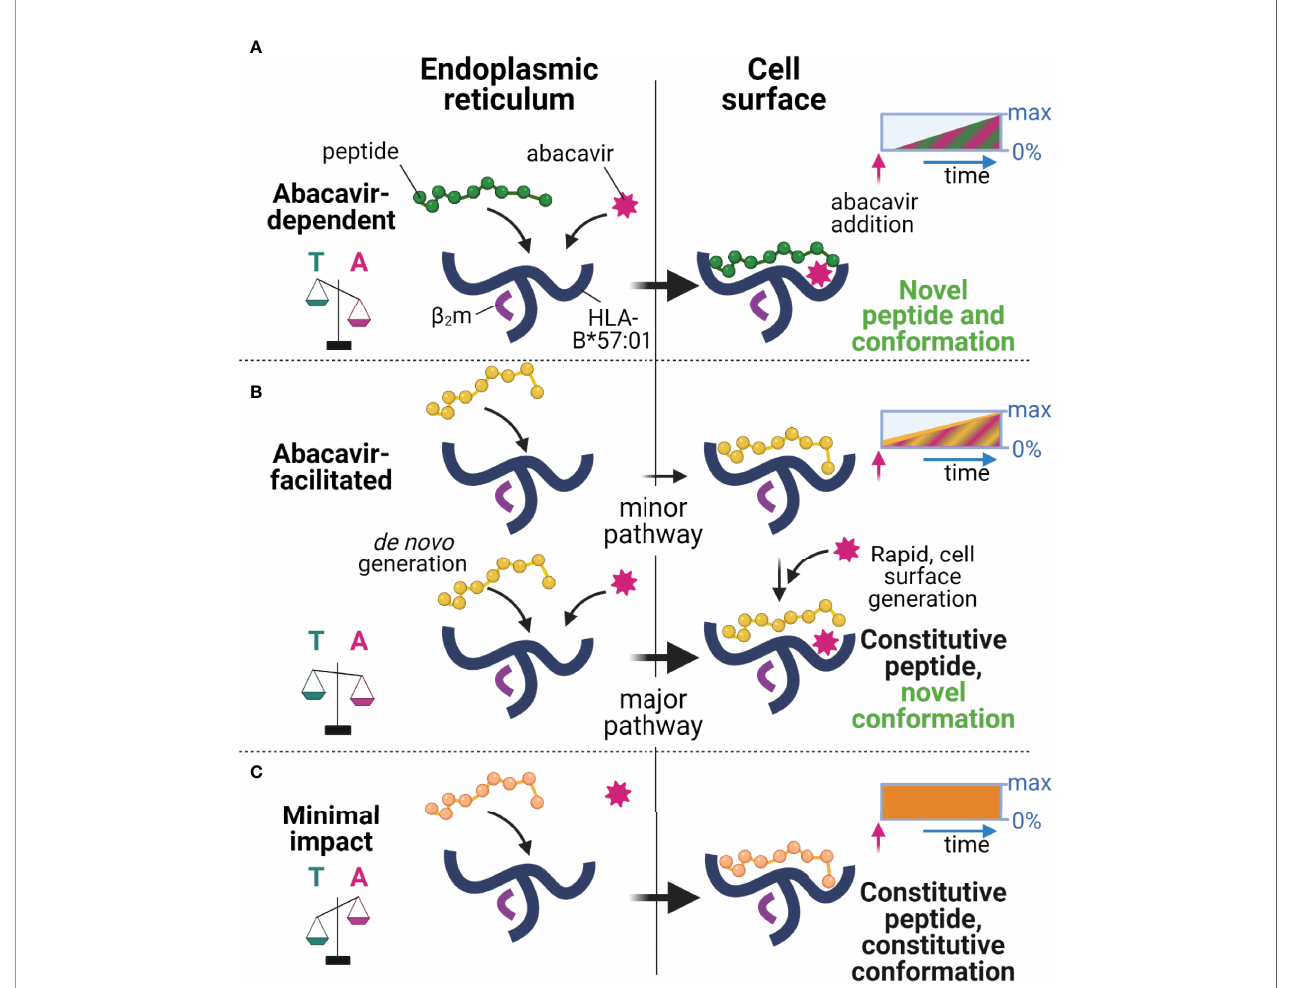
FIGURE 8 | Proposed model of peptide-loading of HLA-B*57:01 in the presence of abacavir. (A) When abacavir is present, abacavir-dependent peptides are loaded into HLA-B*57:01 within the endoplasmic reticulum (left). For the abacavir-dependent peptides in our panel, loading was highly dependent on abacavir as compared to tapasin, represented by the scales tipping towards abacavir (magenta, A), as opposed to tapasin (teal, T). After a slight delay consistent with de novo complex generation in the ER and progression through the secretory pathway, this generates conformationally novel HLA – abacavir – peptide complexes at the cell surface (right, novel self-peptide and novel conformation). The inset box represents the increasing appearance of cell surface complexes (0% – max) incorporating abacavir-dependent peptides (green) and abacavir (magenta hatching) over time (blue arrow) after abacavir addition (pink arrow), until a maximum is reached (not to scale). (B) Abacavir-facilitated peptides are part of the constitutive immunopeptidome (upper panel). For the abacavir-facilitated peptides in our panel, tapasin aids loading in the endoplasmic reticulum in the absence of abacavir, and peptide-loaded HLA traf fi c to the cell surface. On addition of abacavir, abacavir can load into these HLA-peptide complexes at the cell surface generating novel conformations/stabilising the structure (constitutive peptide, novel conformation), contributing immediately to cellular immunogenicity. In addition, de novo generation of HLA-abacavir-peptide complexes occurs within the endoplasmic reticulum, with both abacavir and tapasin promoting peptide binding (lower panel). As such abacavir-facilitated peptides are present in the immunopeptidome prior to abacavir addition (inset box, yellow), with immediate loading of abacavir at the cell surface as well as during de novo complex generation, contributing an increasing number of abacavir occupied HLA from the time of abacavir addition (inset box, magenta hatching). (C) These changes occur against a background of constitutive peptides which maintain a similar contribution to the immunopeptidome regardless of the presence of abacavir (minimal impact, inset box, orange), whilst a proportion of constitutive peptides are reduced in presentation (inhibited, Figure 1 , not shown here). This fi gure was created with